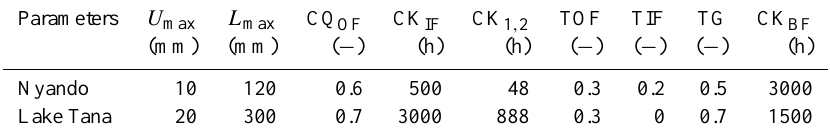
Table 2c. Calibrated parameters of the NAM model for Nyando and Lake Tana catchments. Parameters